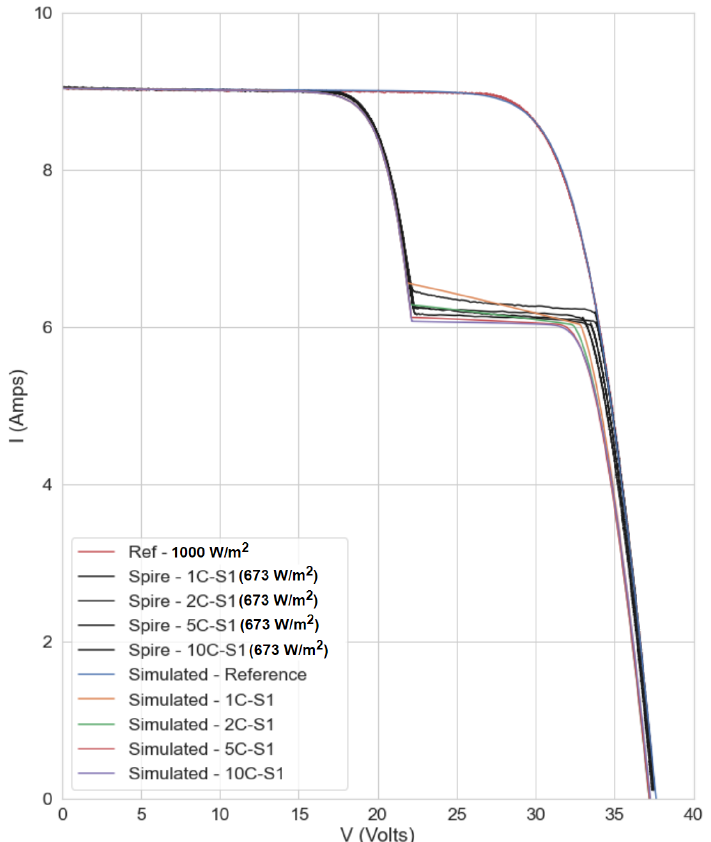
Figure 7. A comparison of the module-level partial soiling across multiple cell-mapping configura- tions for simulated and measured IV curves shows close matching